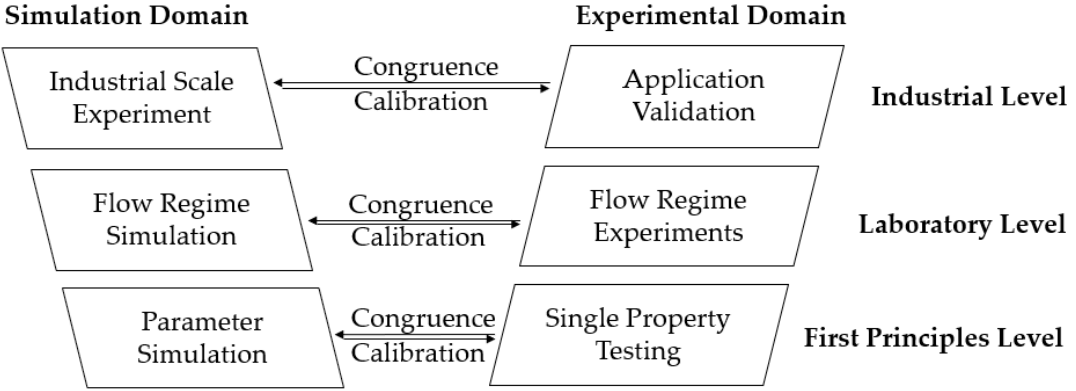
Figure 8. The V ‐ model for DEM calibration and validation (adapted from [63]). Figure 8. The V-model for DEM calibration and validation (adapted from